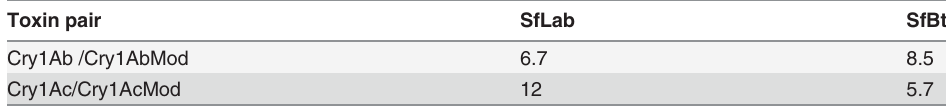
Table 2. Potency ratio for Cry1AMod toxin relative to native toxins. Toxin pair